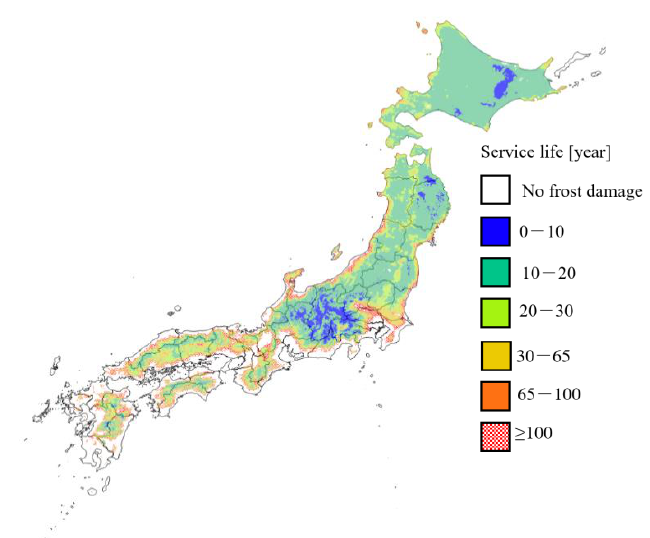
Figure 9. Distribution map of service life considering the effect of pore structure change due to drying with an initial durability factor of 90. Solar radiation conditions: north side; curing conditions: 20 °C drying; freezing and thawing conditions: thawing in air; and water-to-cement ratio: 0.45.